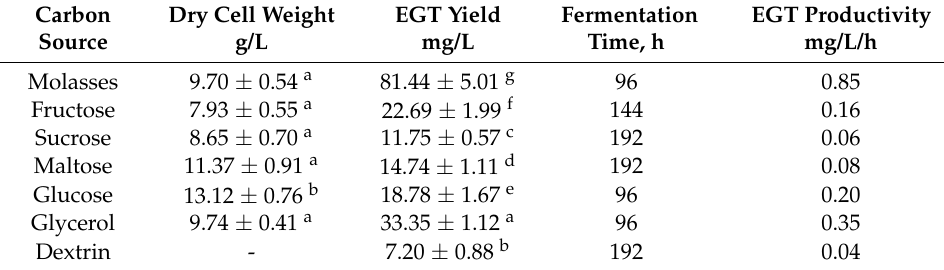
Table 2. Effect of different kinds of carbon sources on EGT